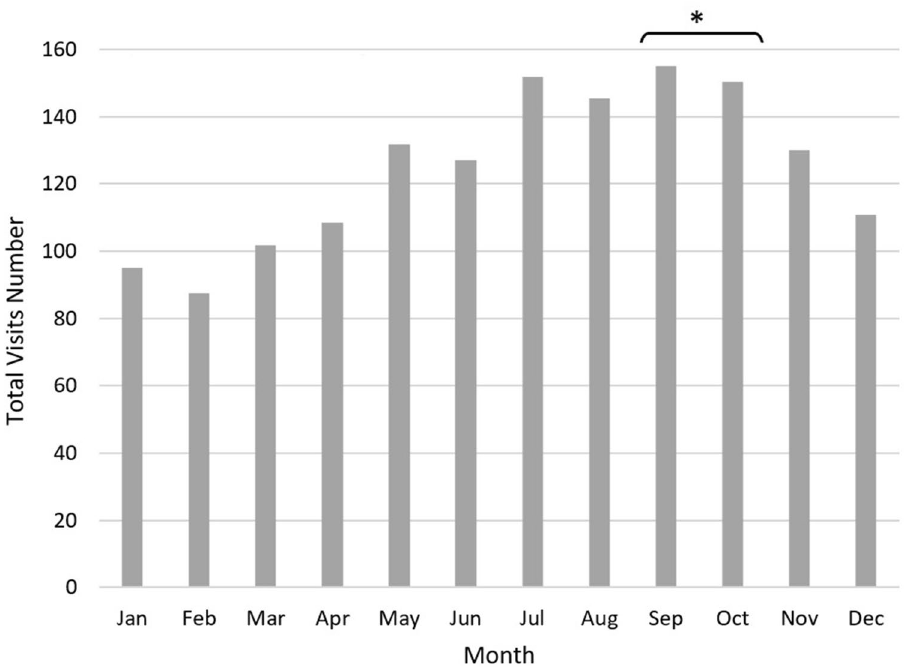
Figure 1. Average monthly emergency room visits due to renal colic. *Months in which Yom Kippur (single day fasting)